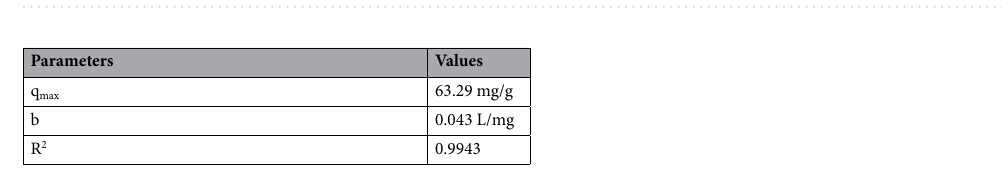
Figure 9. Langmuir isotherm model for Cu(II) ions adsorption onto Cs-g-PVP/f-MWCNTs (hybrid II).